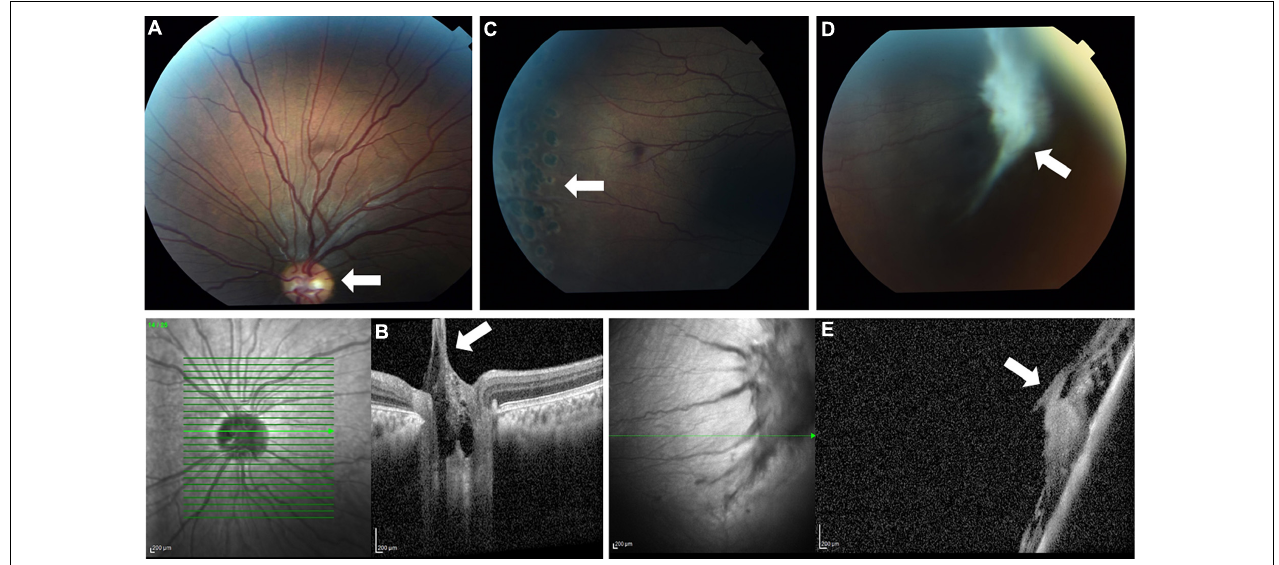
FIGURE 1 | Fundus photo (A) and optical coherence tomography (OCT) (B) showing Bergmeister’s papillae and straightened retinal vessels (white arrows). Laser photocoagulation scars are seen (arrow) on fundus examination (C) . A later fundus image (D) and OCT (E) show a large new vitreoretinal traction (white arrows).